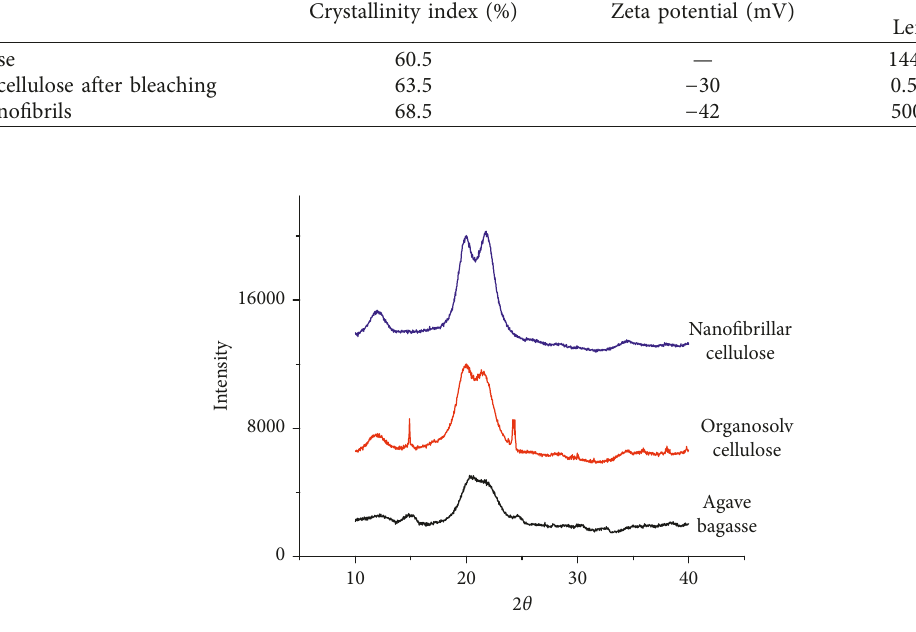
Figure 4: XRD spectra of agave bagasse fiber, organosolv cellulose, and nanofibrillar cellulose.